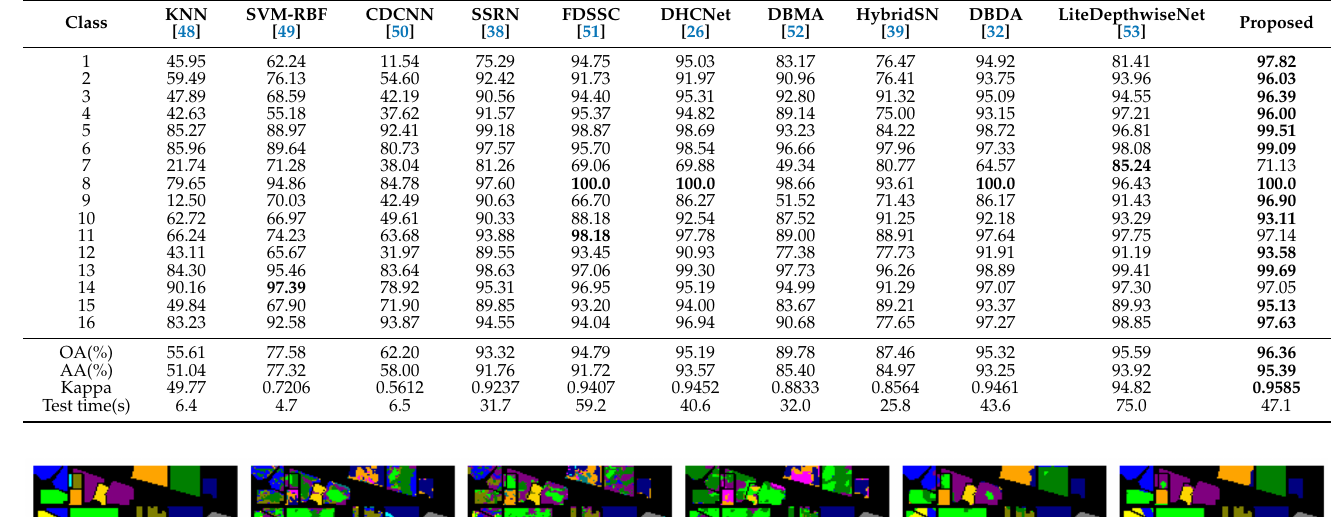
Table 6. KPI (OA, AA, Kappa) on the Indian Pines (IN) dataset with 3% training samples.